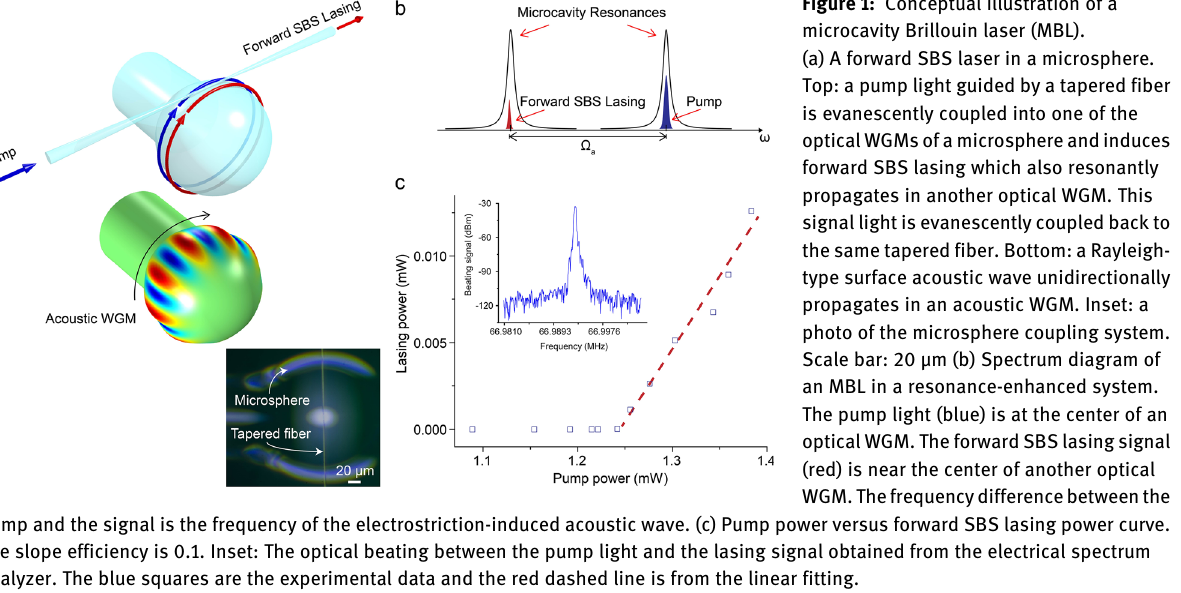
Figure 1: Conceptual illustration of a microcavity Brillouin laser (MBL). (a) A forward SBS laser in a microsphere. Top: a pump light guided by a tapered fiber is evanescently coupled into one of the opticalWGMsofamicrosphereandinduces